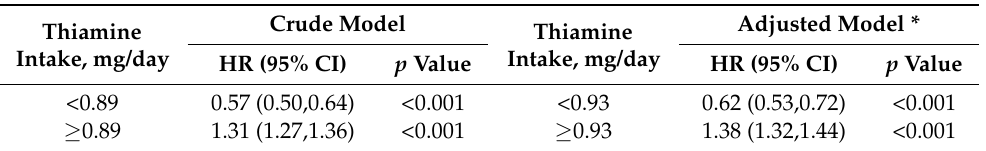
Table 2. Threshold analyses of dietary thiamine intake (per SD increment, 0.35 mg/day) on new-onset hypertension using 2-piecewise regression